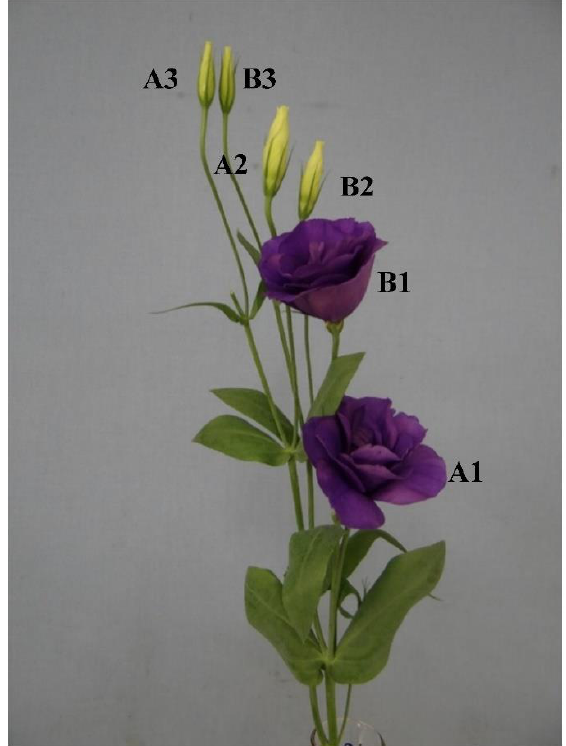
Figure 1. Flowering stem of lisianthus ‘Mariachi Blue’.